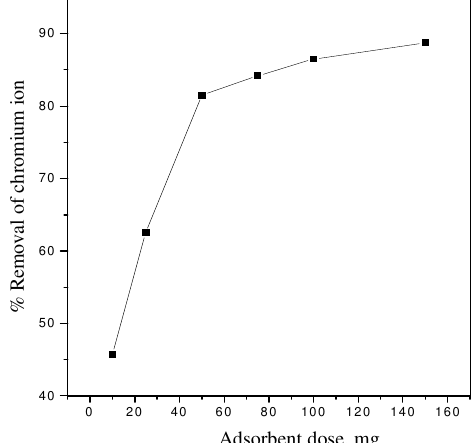
Figure 2. Effect of adsorbent dose on the removal of chromium ion by PDC [Cr]=20 mg/L, pH=7; Contact time=60